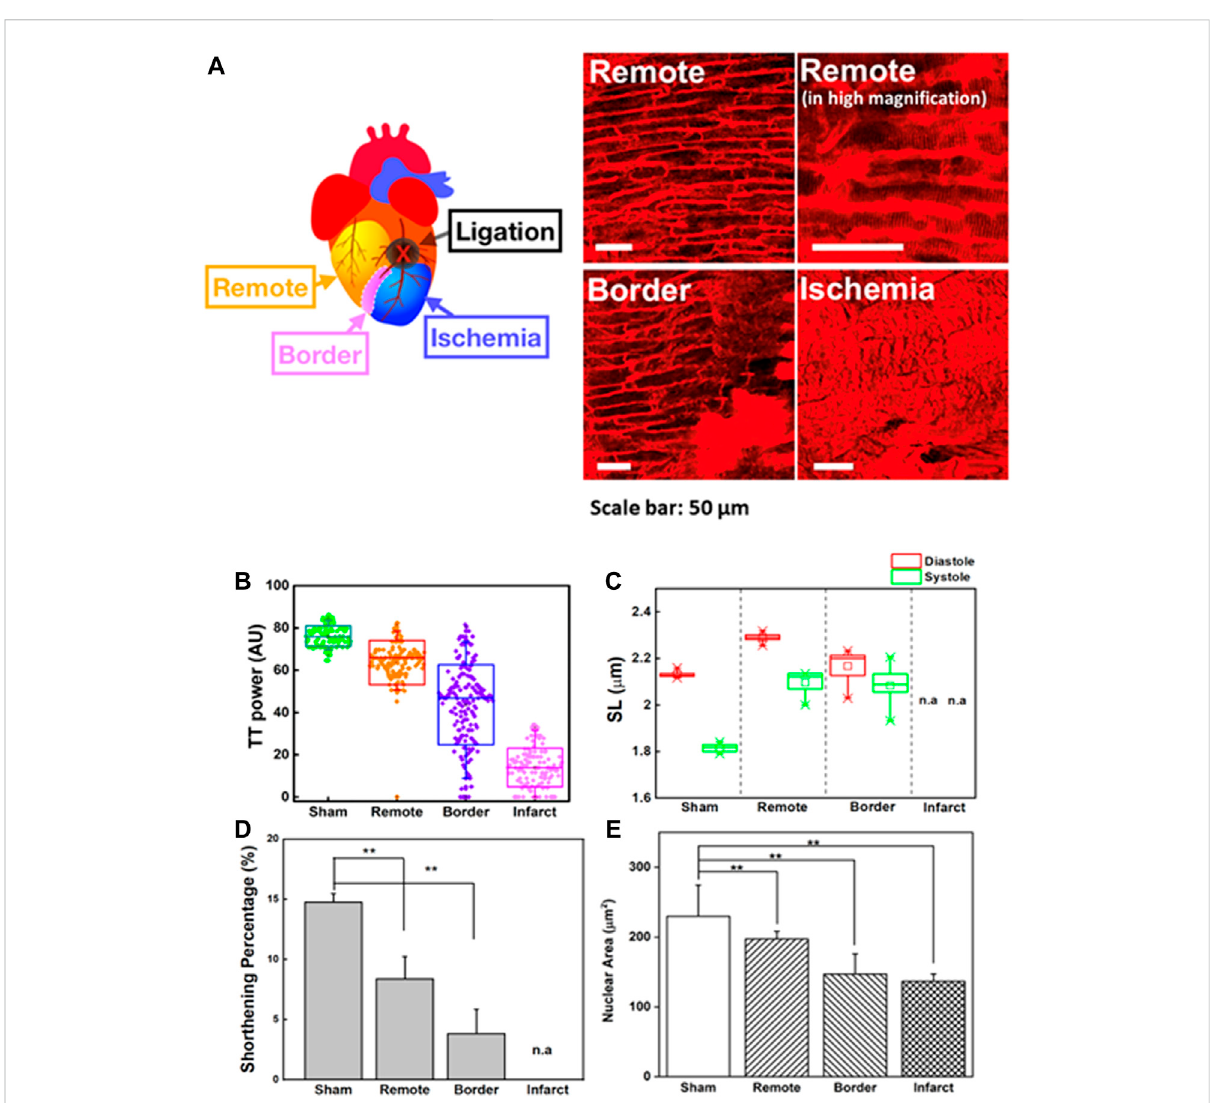
FIGURE 4 (A) Two-photon images of cardiomyocytes in a different region of the heart in an MI model. Remote area is far away from the point of ligation where the cardiomyocytes are normal. Higher magni fi cation image of the same remote area is provided to reveal the fi ne structures of sarcomeres. Scalebar: 50 µm. (B) T-tubule system regularity analysis oftheheartinsham anddifferentregions ofMImodels (remote, border, andinfarct).Higher TT power indicates ordered organization of T-tubule system, (C) Sarcomere length (SL) variation in the systolic and diastolic states of the sham and different regions of MI models (remote, border, and infarct). (D) The sarcomere shortening percentage (% Δ SL ) of the heart in the sham and in different regions MI models (remote, border, and infarct). (E) The nuclear area in different regions of the heart in the MI model (remote, border, and infarct) compared to the sham model ( N = 3, mean ± standard